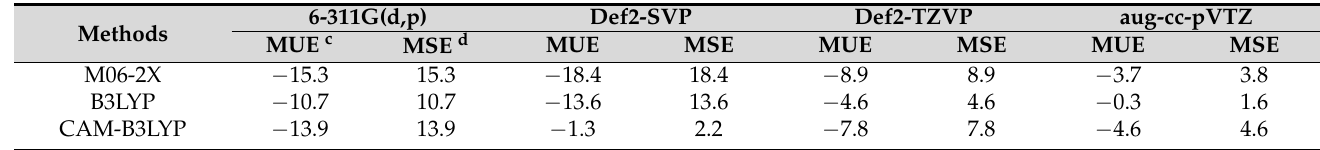
Table 1. Benchmark results of isotropic polarizabilities ( α iso ) of several density functionals and basis sets for 20 amino acids. a Units are in Bohr 3